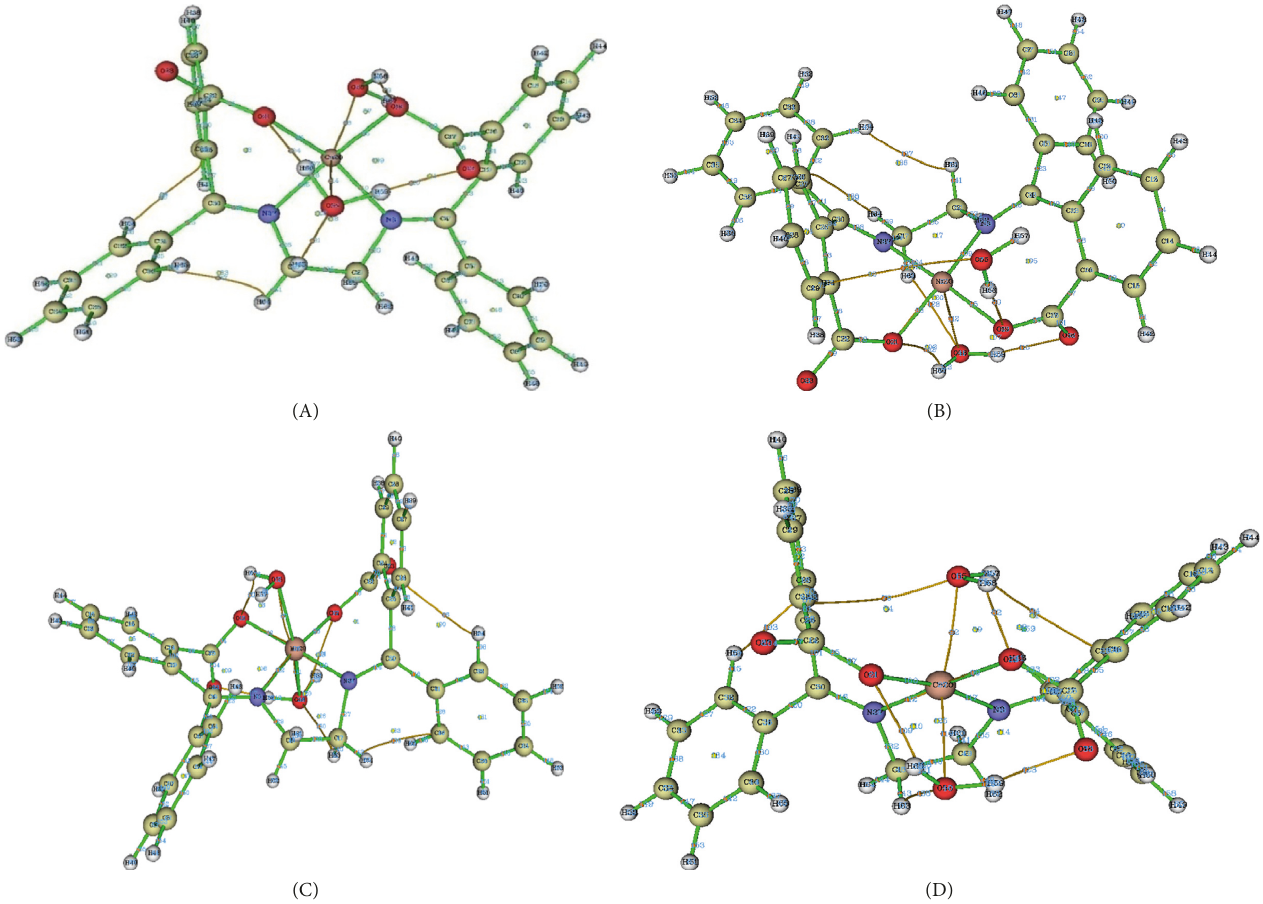
Figure 3: Molecular graphs of EDA2BB complexes computed based on their gas phase optimized geometries at the BP86-D3(BJ)/def2-TZVP(-f) level of theory. The BCPs are the small red spheres around the centre of the bond paths. The bond paths are the brown or green colored